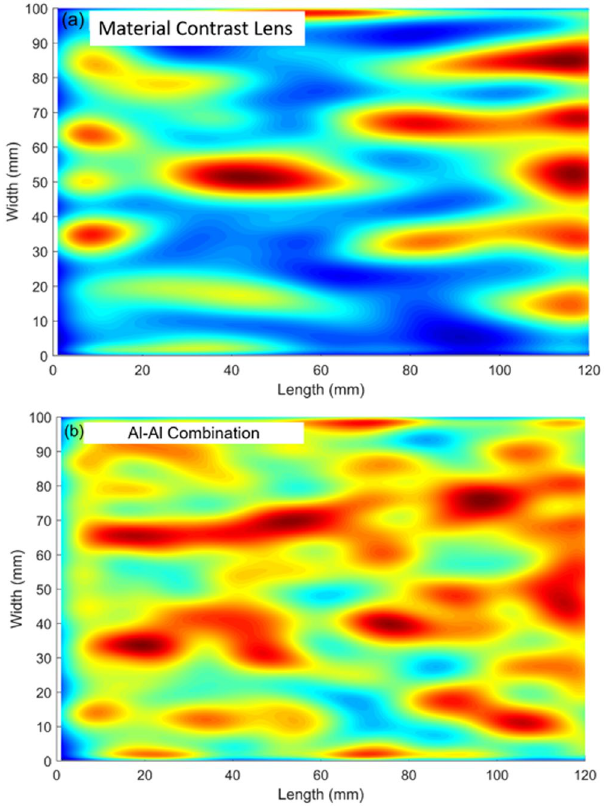
Figure 4. Top View. 2D scan representation obtained from experimentally monitored wave amplitude on the surface of plate across the interface. (a) Material contrast lens (b) Al-Al combination. Focusing is observed at 47 mm from the interface in material contrast lens compared to Al-Al combination.